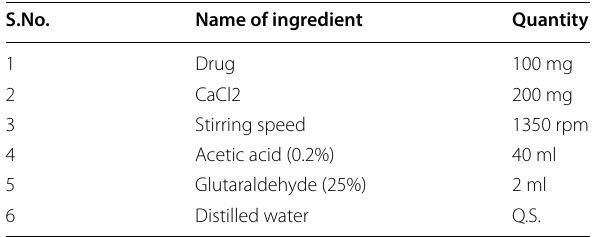
Table 4 Composition of optimized vancomycin HCl microspheres (OVMS)